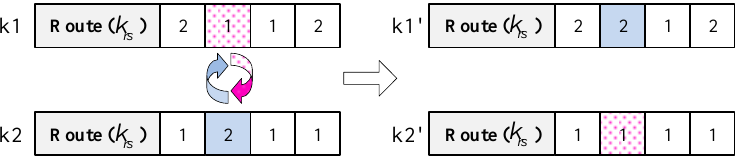
Figure 6. Illustration of mutation for sub-chromosome EM. For sub-chromosome k, let us randomly select a gene and regenerate this gene in the feasible region. 3.2.5 Selection Process In this paper, non-dominated sorting and crowding distance-based fitness assignment strategies of NSGA-II algorithm are used to implement competitive selection [40].